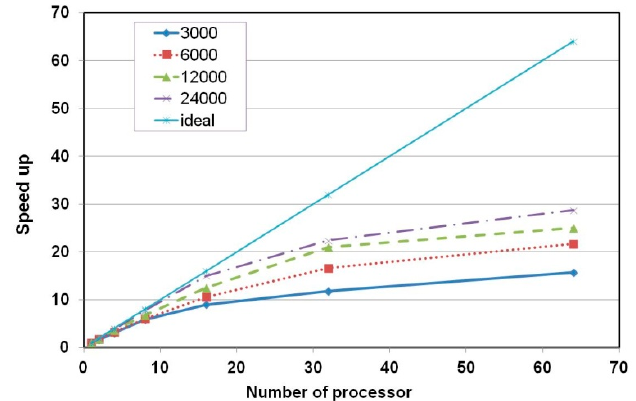
Figure 8. Speed-up according to the number of nodes and processors. Materials 2019 , 12 , x FOR PEER REVIEW 16 of 24